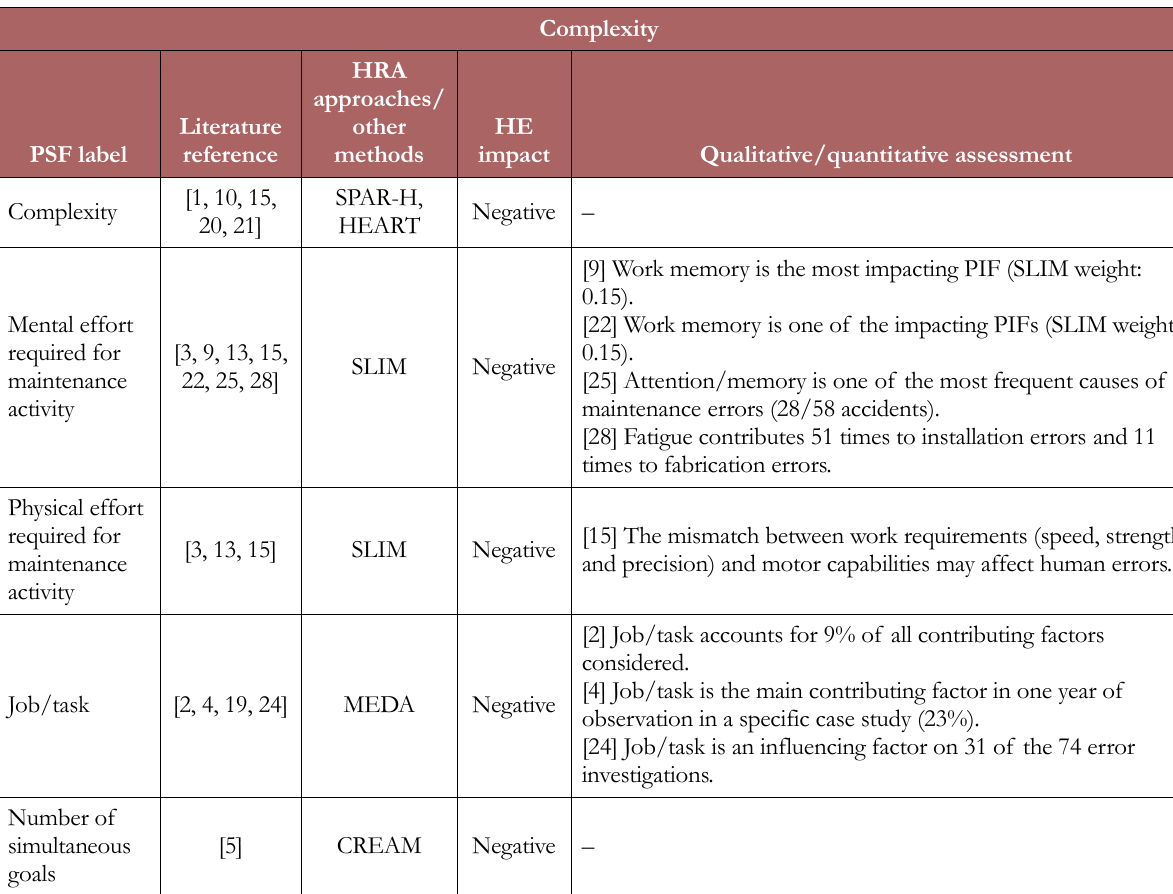
Table 11. Taxonomy of maintenance PSFs: complexity